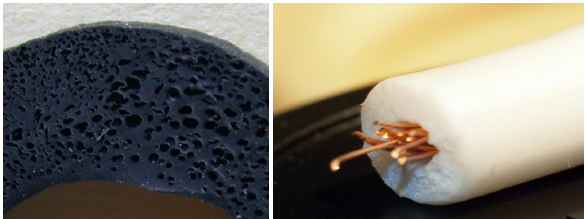
Figure 1: Sample plates with two ribs applied in aviation industry by the